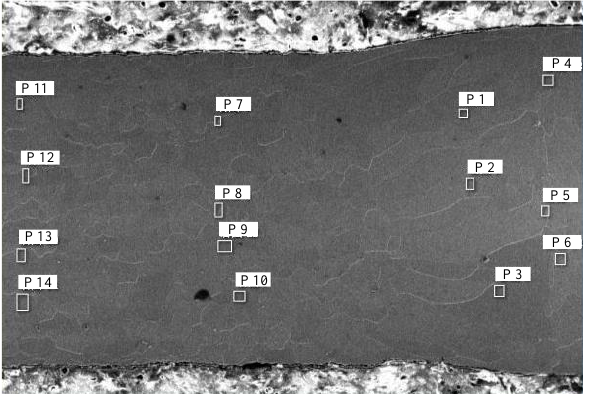
Figure 12. The measurement positions of the EDS point analysis on the cross section of the joint welded according to parameter (7 (0.5) #), P1–P14 indicates the sequence of EDS measurement positions and the white box indicates the EDS measurement position. Table 7. EDS results of point analysis on the cross section of the joint (7 (0.5) #) in Figure 12. Elements (wt.%) Position Test No. Position Test No. Position Test